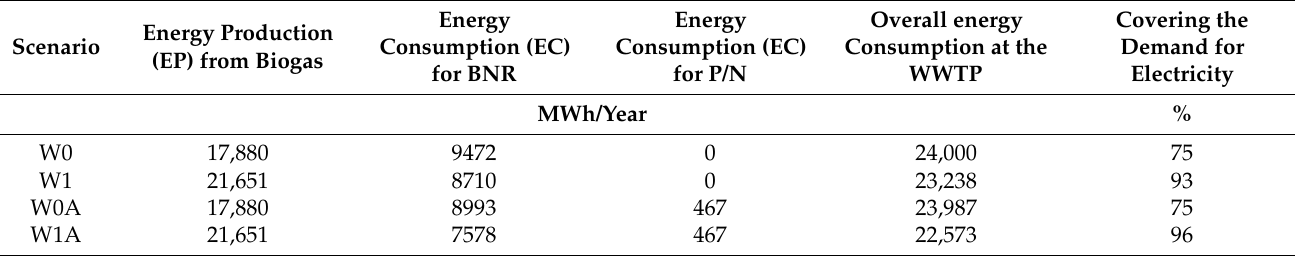
Table 6. Evaluation of scenario in terms of energy gains and